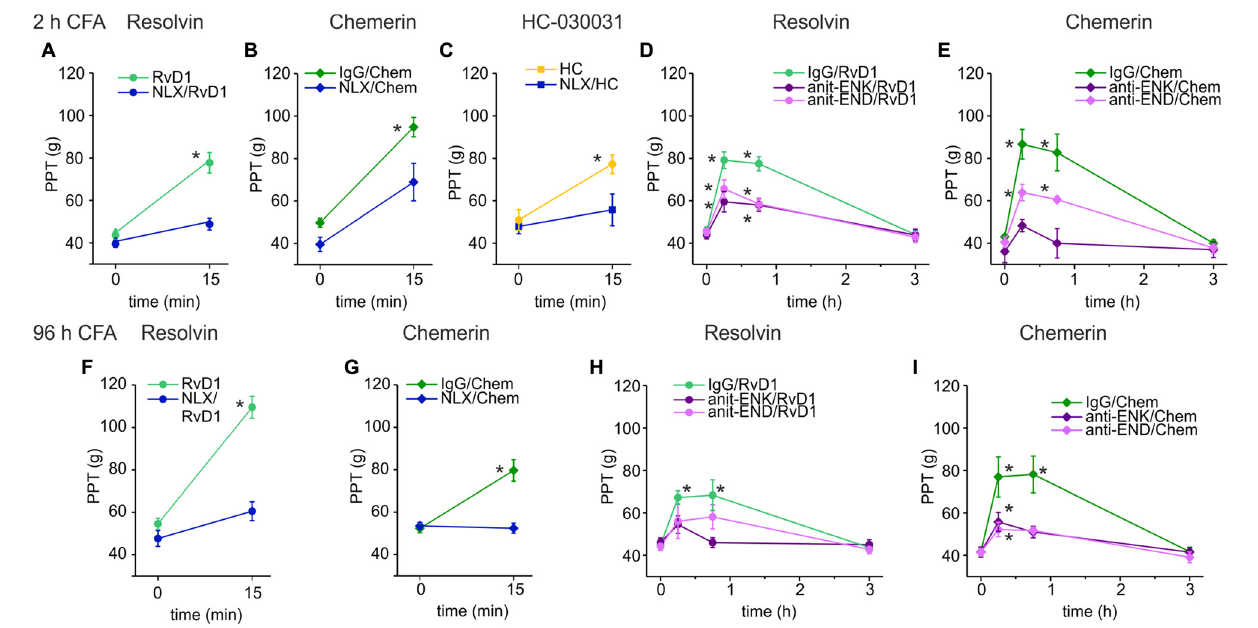
FIGURE 2 | Reversal of RvD1-mediated antinociception by peripheral blockade of the µ -opioid peptide receptor (MOR) or of endogenous opioid peptides in rats. Antinociception by RvD1 (A,D,F,H) , Chem (B,E,G,I) , and HC-030031 (HC, C ) in CFA-mediated hind paw inflammation on mechanical hypersensitivity was reduced by local co-application of naloxone (A–C,F,G) or local co-injection of antibodies against the endogenous opioid peptides β -endorphin (END) and met-enkephalin (ENK; anti-END/anti-ENK; D,E,H,I ) at indicated time points in the early (A–E) and the late phase (F–I) of CFA-induced inflammation. Baseline inflammatory hypersensitivity was measured before injection of RvD1, Chem, or HC at CFA-time points indicated above the graphs ( n = 6 per group, mean ± SEM; two-way ANOVA RM post hoc Holm-Sidak, ∗ p < 0.05 compared to baseline pre-injection values, 0 h).